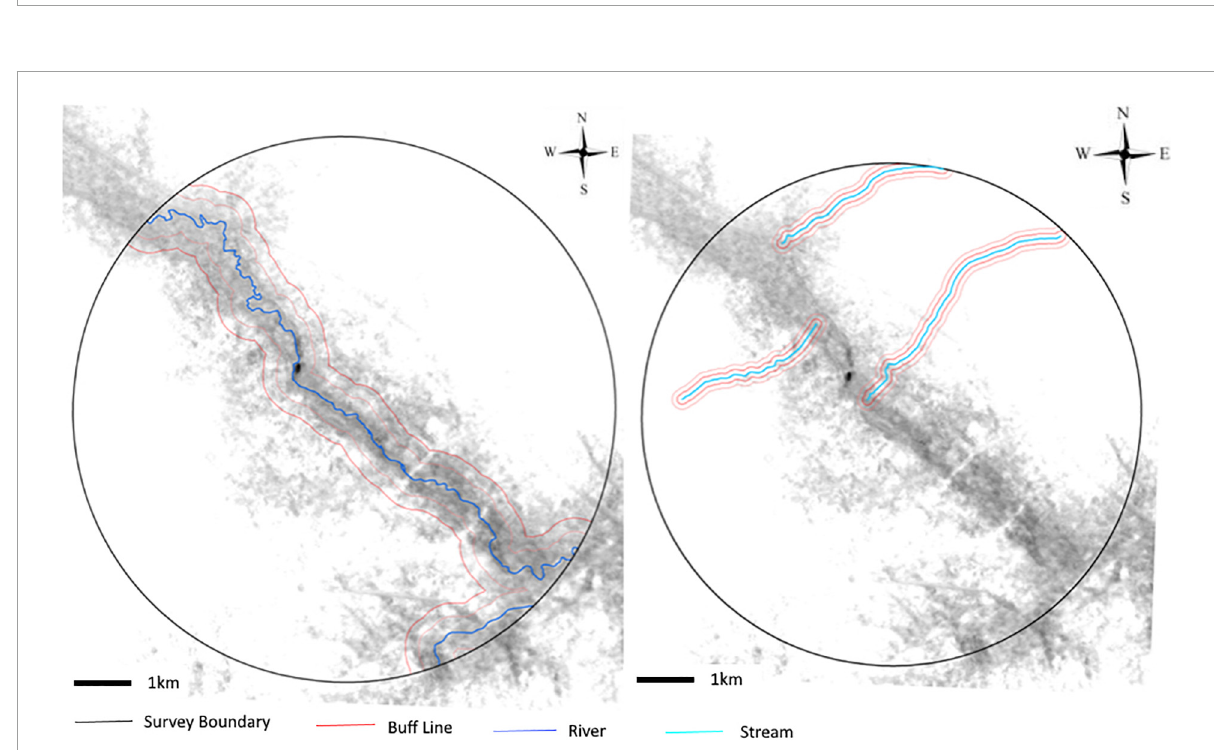
FIGURE8 (Left) Image indicates the extended meadow zones along the main rivers in the 5 km radius survey area. (Right) Image indicates the extended meadow zones along the streams in the 5 km radius survey